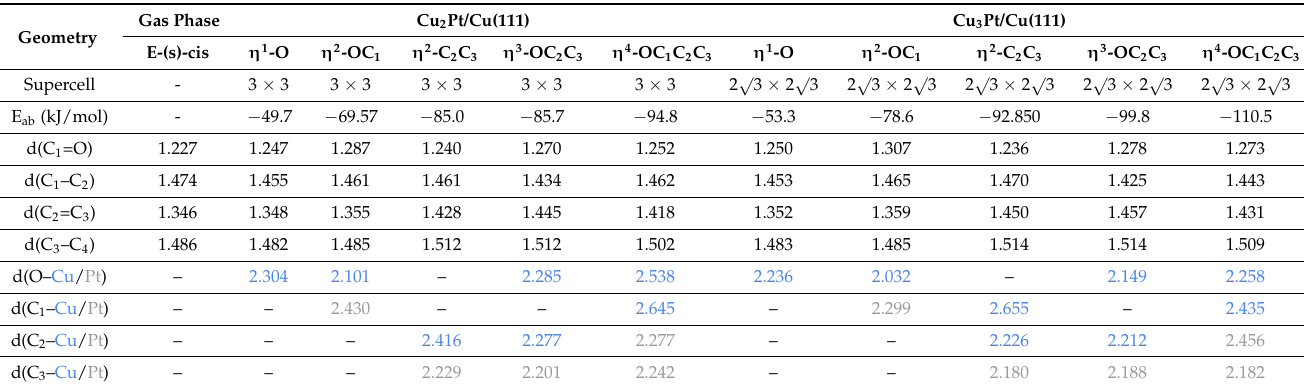
Table 1. Calculated bond lengths for the E-(s)-cis crotonaldehyde in the different configurations considered in this work. Values for bonding to either Cu or Pt are indicated by the color of the numbers, blue for Cu and grey for Pt.